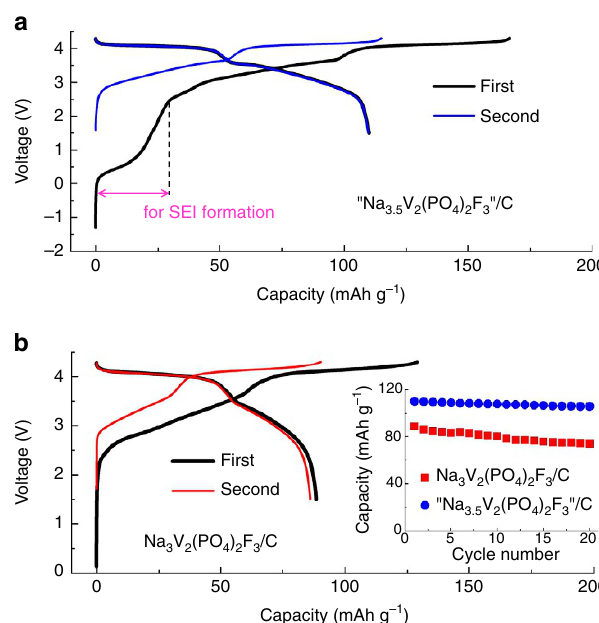
Figure 6 | Performances of C/‘Na 3 þ x V 2 (PO 4 ) 2 F 3 ’ Na-ion cells. The voltage-composition profiles are reported for two first cycles for cell C1 using Na 3 V 2 (PO 4 ) 2 F 3 ( b ) and cell C2 using ‘Na 3.5 V 2 (PO 4 ) 2 F 3 ’ ( a ). The weight ratio of cathode to anode is 2.7 and 1.9 for C1 and C2 cell, respectively. The cells were cycled at a 0.2C rate (C rate being defined as the extraction of 2 Na from NVPF). For both cells a 1M NaClO 4 in EC/DMC (50/50 by volume) electrolyte was used. The capacity is calculated based on the weight of positive materials. Inset in ( b ) shows the capacity retention in the first 20 here only on the performance for the optimum x value. This value